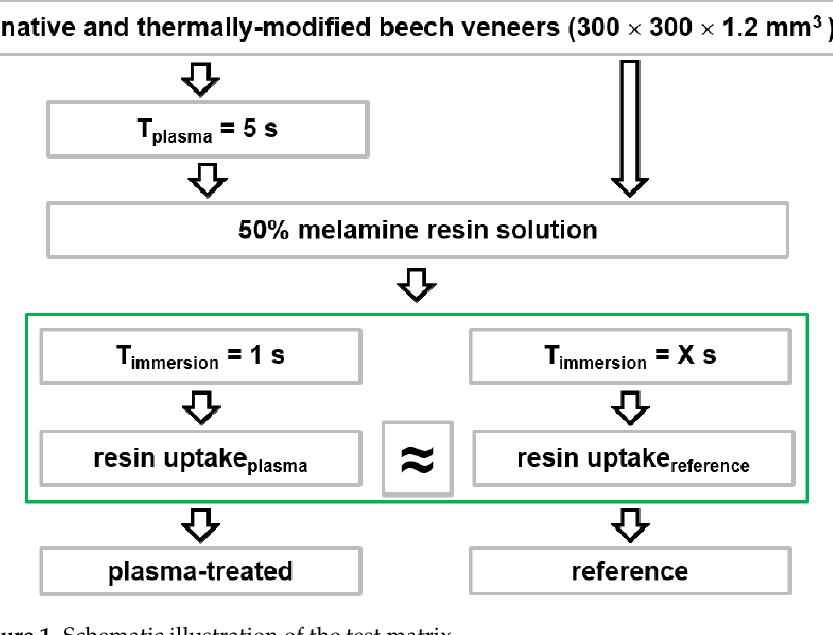
Figure 1. Schematic illustration of the test matrix.